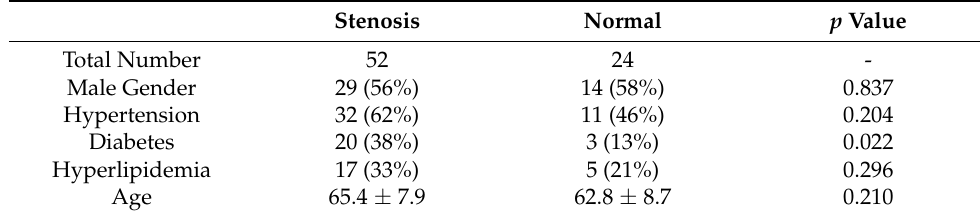
Table 1. Participant information.